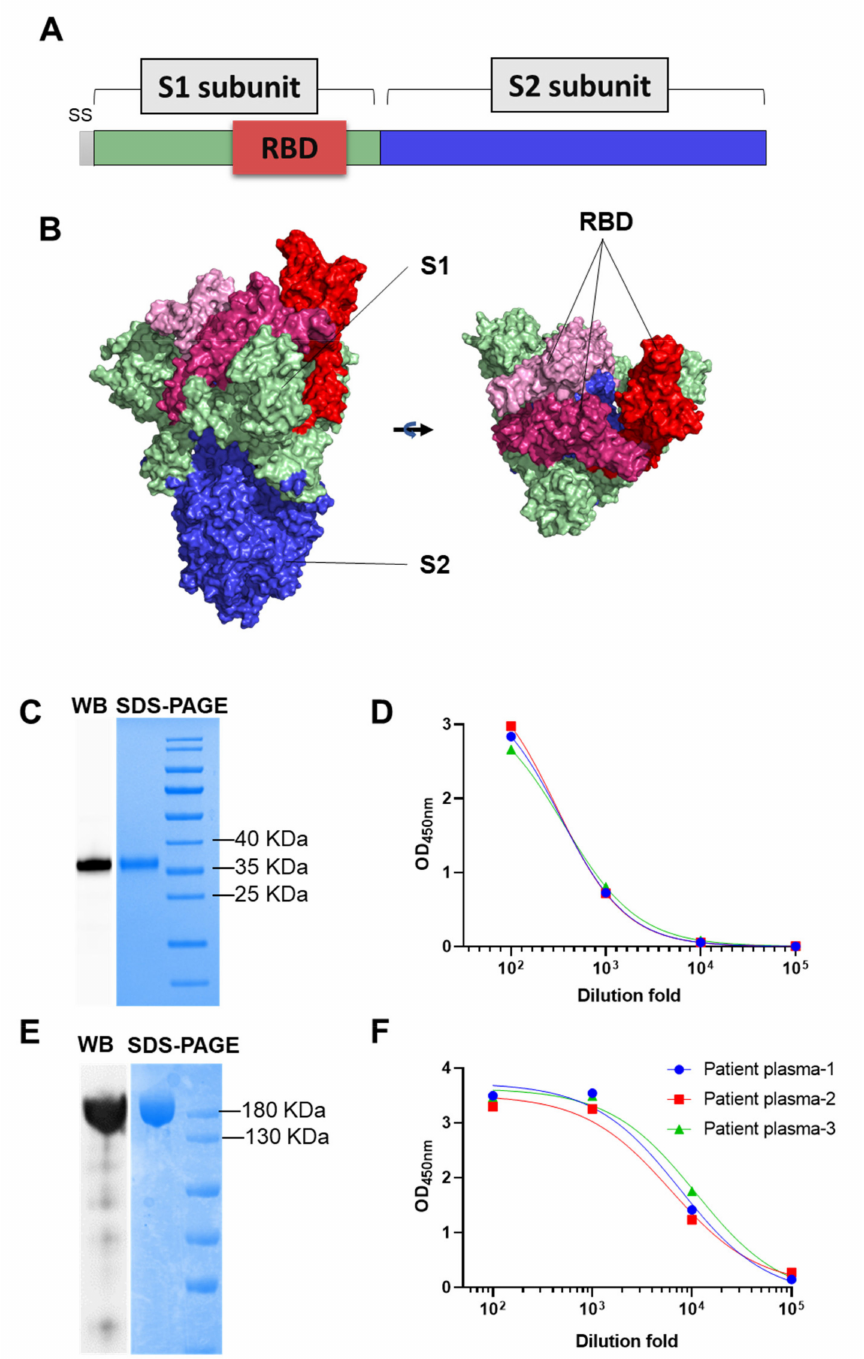
Figure 1. Biochemical and antigenic characterization of purified RBD and S protein. ( A , B ) Graphical representation of S protein (S1 and S2) and receptor binding domain (RBD). S1 subunit in light green, S2 in blue, RBD in red. Images were edited with PyMOL and the PDB accession number of S protein is 6z97. ( C , D ) SDS-PAGE, Western blot (WB) of purified RBD and RBD ELISA reactivity with COVID-19 convalescent sera. ( E , F ) SDS-PAGE, Western blot (WB) of purified S protein and SELISA reactivity with COVID-19 convalescent sera. Anti-His antibody was used as detection antibody in Western